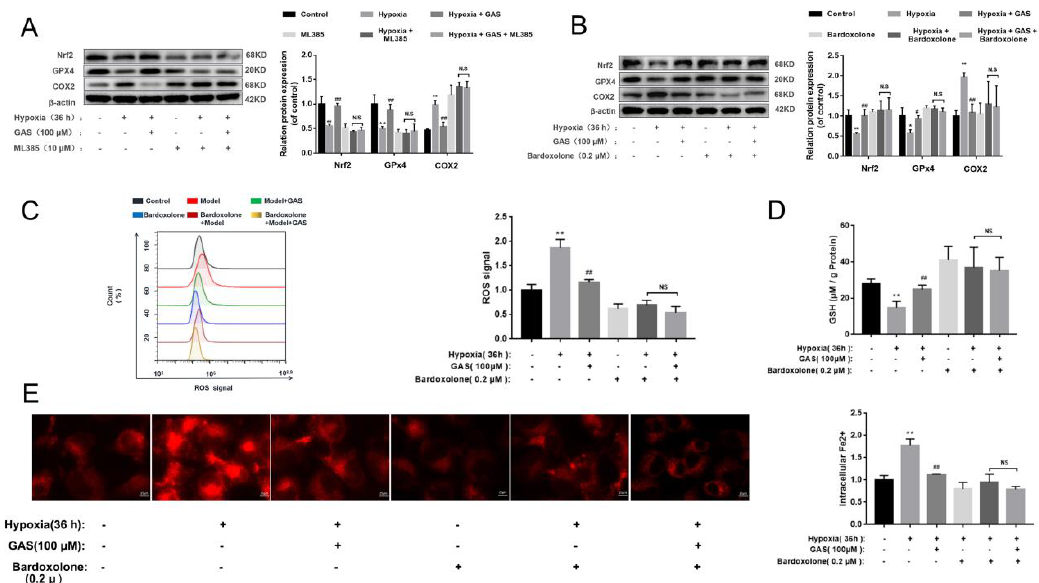
Figure 6. GAS inhibits ferroptosis via the Nrf2/GPx4 Pathway to improve hypoxic injury in HT22 cells. ( A , B ), levels of GPx4 and COX2 in HT22 cells treated with Nrf2 inhibitors (ML385) or Nrf2 agonists (Bardoxolone) were assessed with or without GAS treatment (100 μM) for 36 h ( n = 3) ( C ), intracellular ROS levels were labeled with DCFH-DA (10 μM) and detected by flow cytometry (n = 3) ( D ), levels of GSH in HT22 cells treated with an agonist of Nrf2 (Bardoxolone) were detected with or without GAS treatment (100 μM) for 36 h ( n = 3) ( E ), detection of intracellular Fe 2+ changes using FerroOrange. * p < 0.05, ** p < 0.01, compared to the control group; # p < 0.05, ## p < 0.01 compared to the hypoxia group; NS indicates no significance.